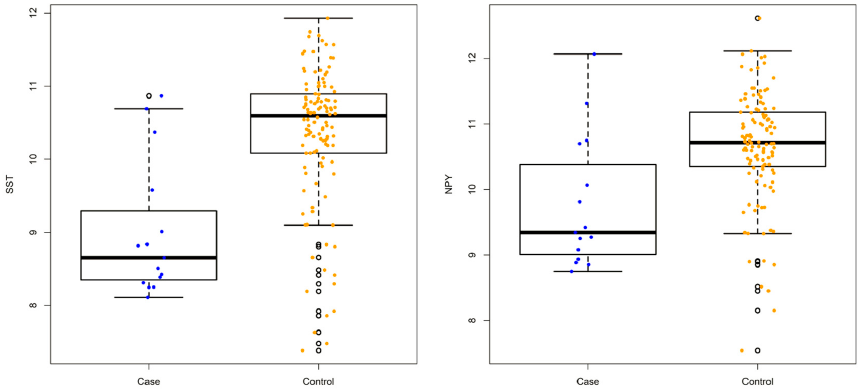
Figure 1. The expression levels of SST and NPY between cases and controls. The x-axis shows the group of cases (blue) and controls (yellow), and the y-axis shows gene expression levels (logFC).